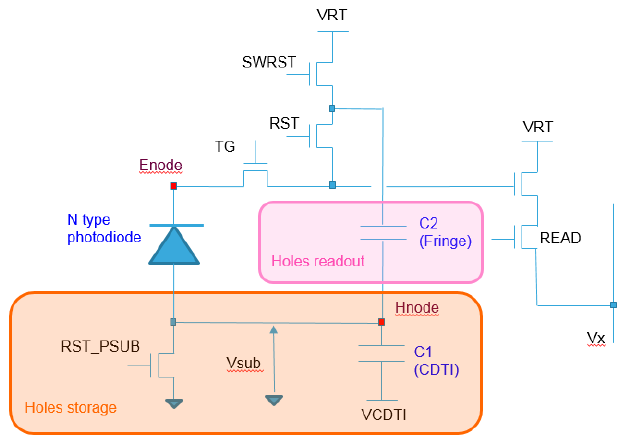
Figure 1. Pixel schematic. TG: transfer gate; RST: reset transistor in high CG mode; CDTI: capacitive deep trench isolation; VRT: positive supply voltage; SWRST: reset transistor in low CG mode; VCDTI: CDTI biasing voltage.